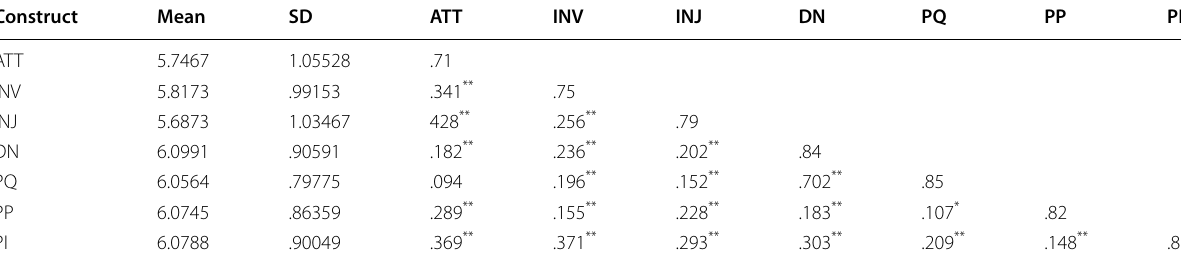
Table 3 Descriptive, correlation matrix, and square root of